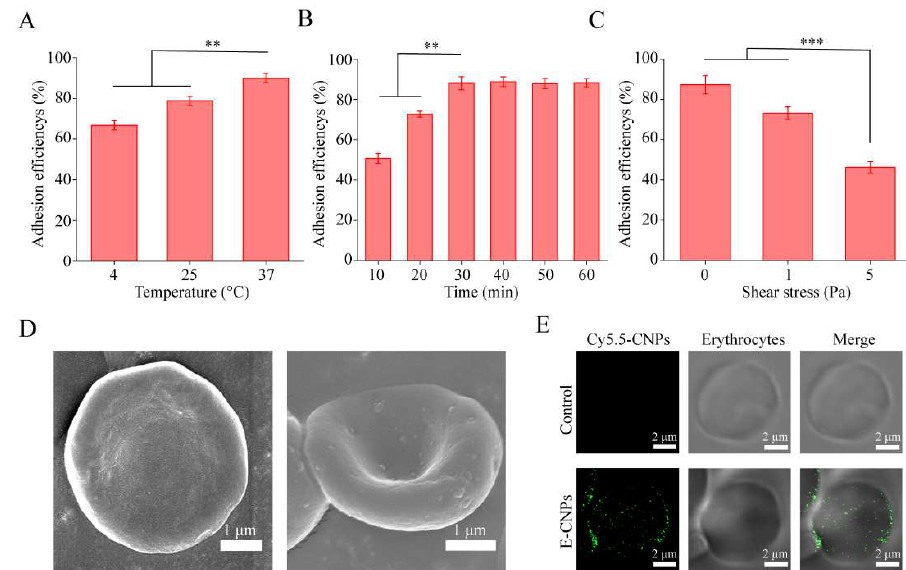
Figure 3. Investigation and characterization of E-CNPs in vitro. The influence of ( A ) incubation temperature and ( B ) incubation time on the adhesion efficiency of CPA-CNPs to erythrocytes. ( C ) CPA- CNPs desorption from erythrocytes under shear stress challenge. Image results of E-CNPs under SEM ( D ) and CLSM ( E ). ( n = 3, mean ± SD, ** p < 0.01, *** p < 0.001).